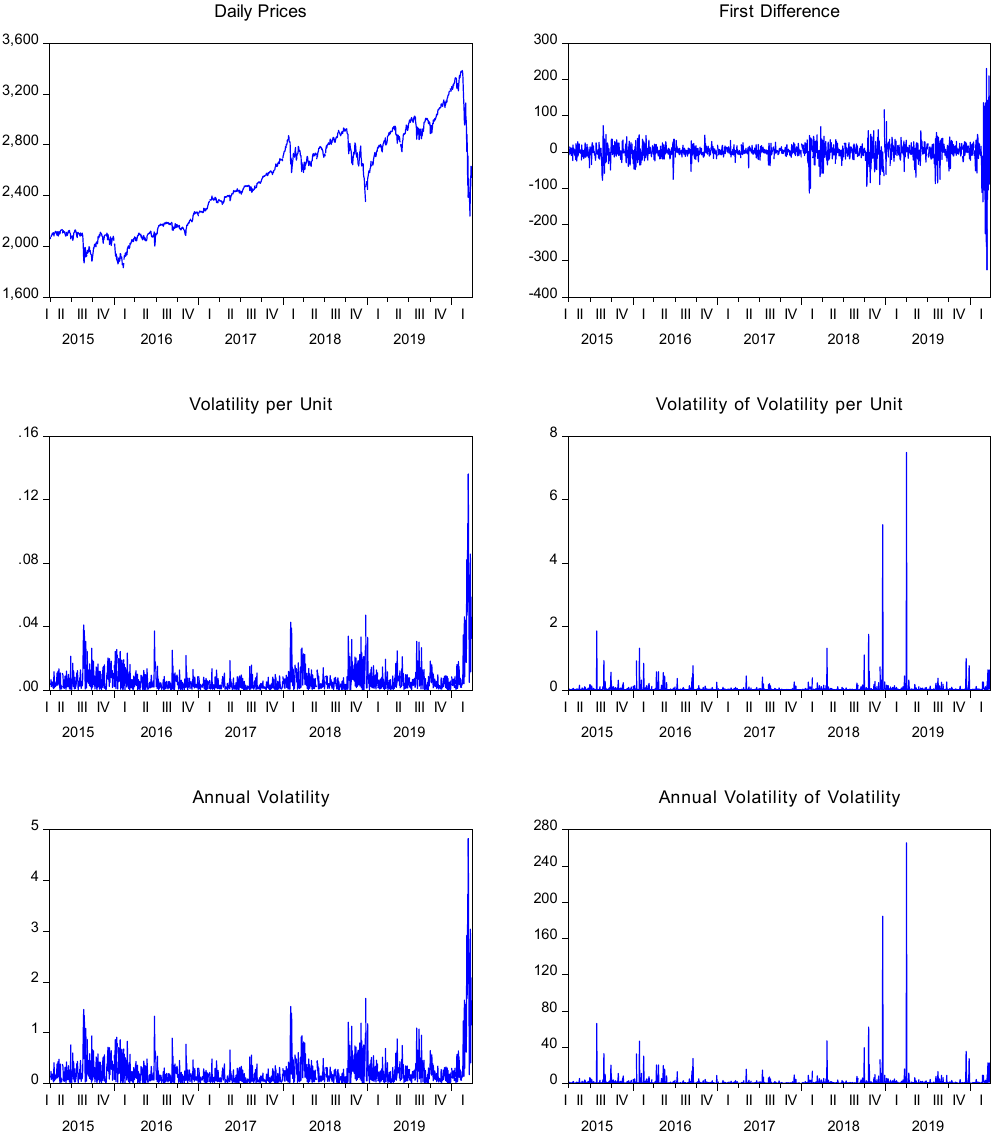
Figure 4. Plot of the S&P 500 daily sample.